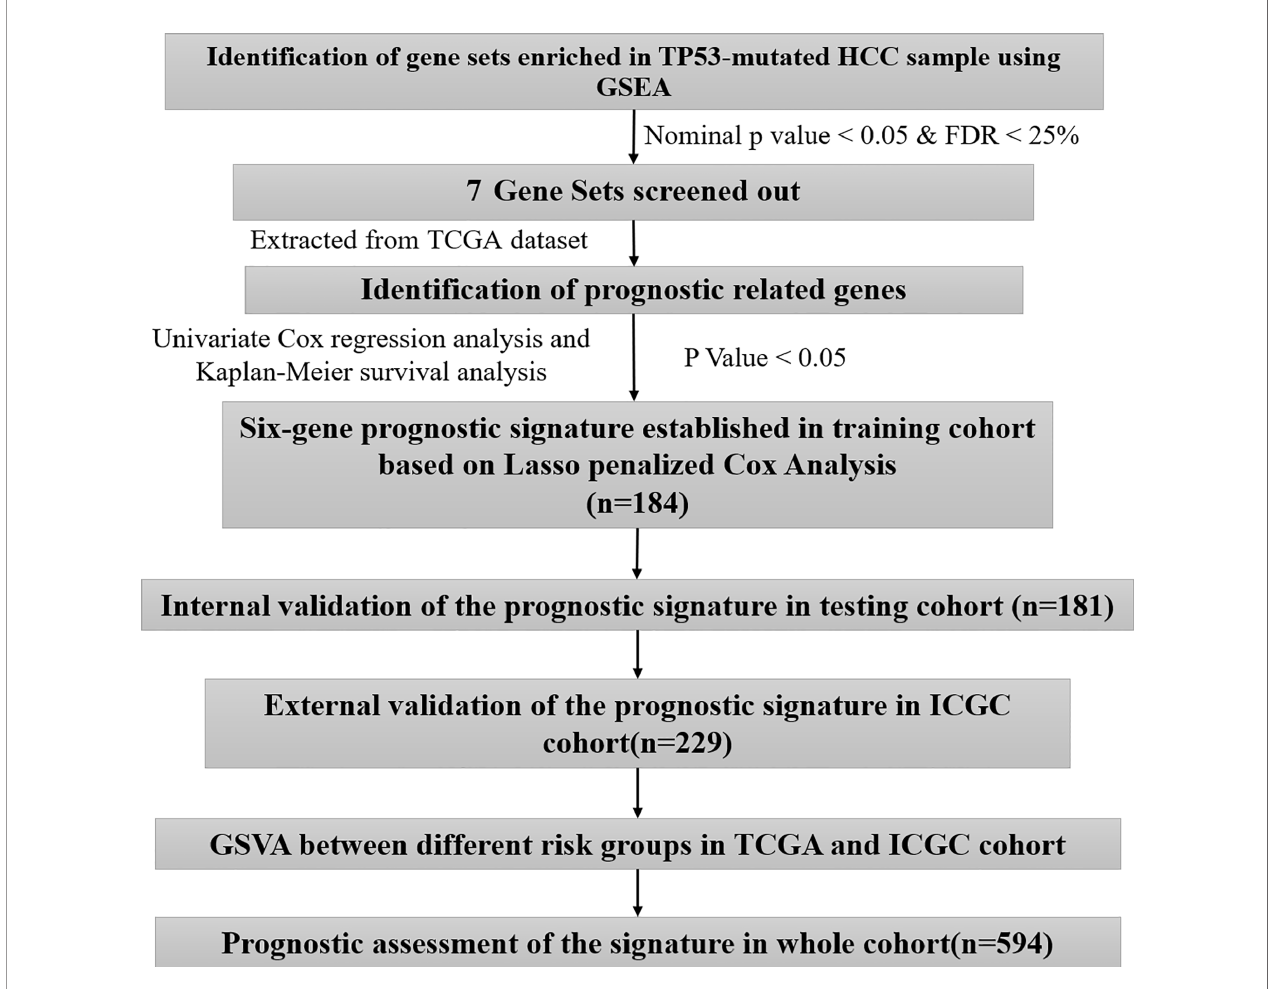
FIGURE 1 | The work fl ow chart of this